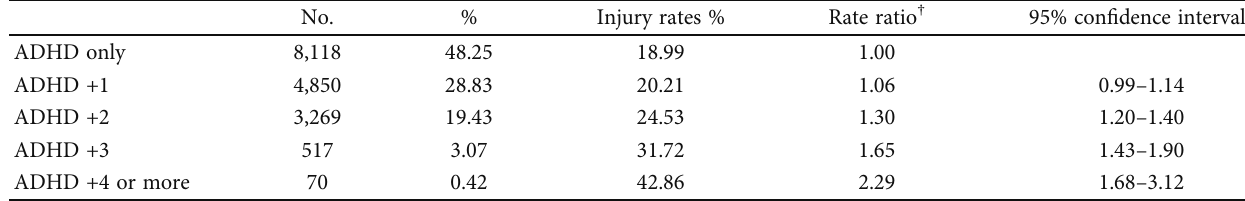
Table 5: Rate of injury among ADHD cases according to the number of comorbid mental health problems.